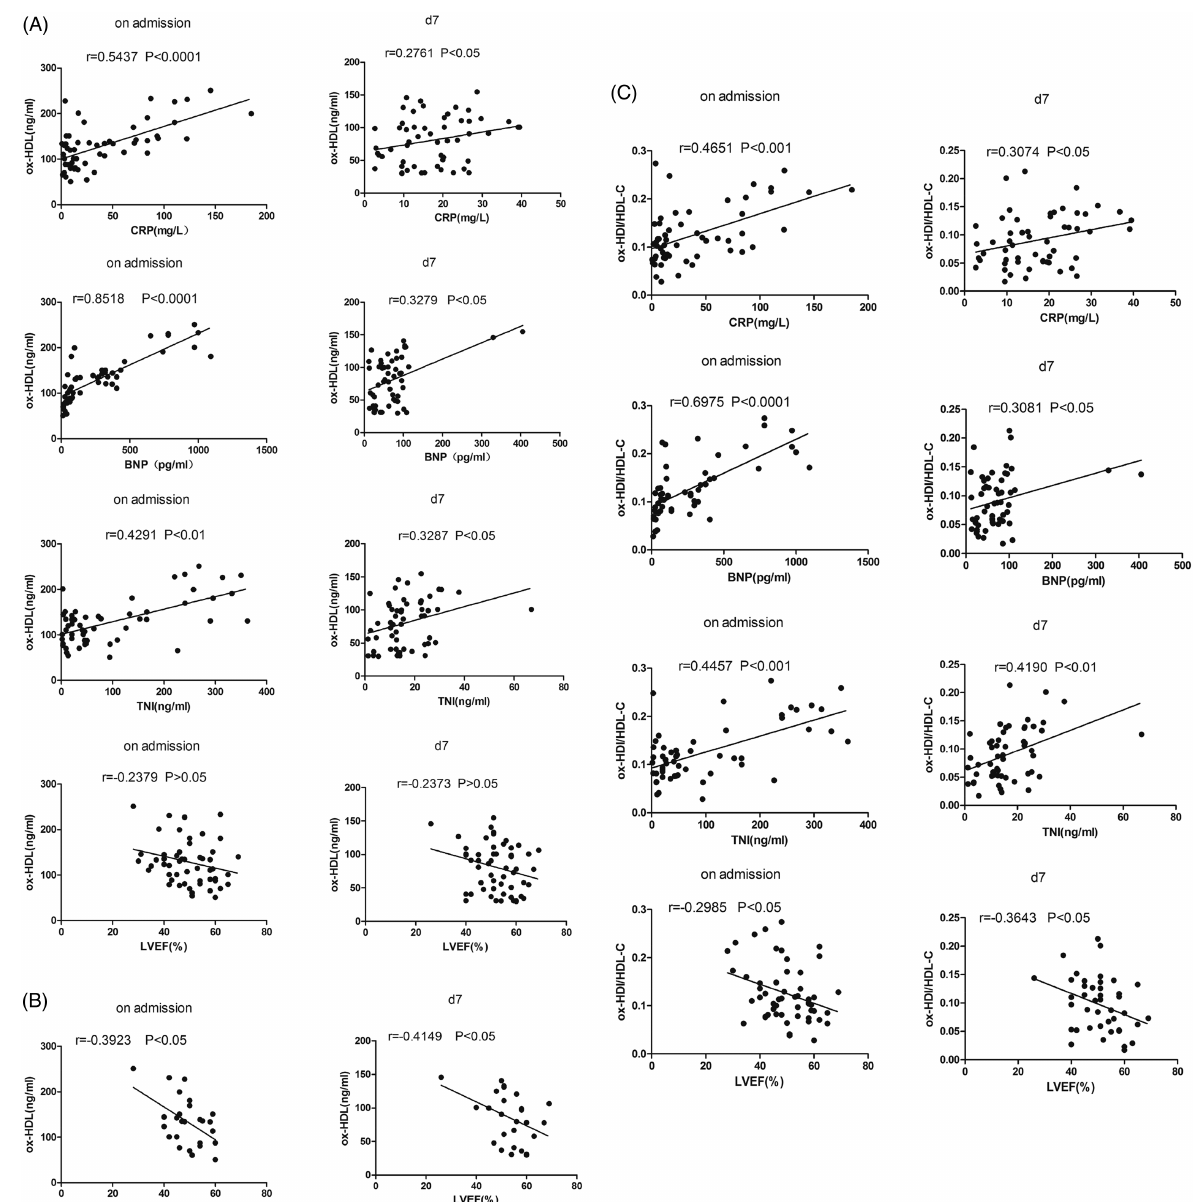
Figure 4. Spearman ’ s correlation analysis. (A) Plasma ox-HDL concentrations were positively correlated with CRP, BNP, and cTNI and were not correlated with LVEF in STEMI patients at each time point. (B) In patients whose culprit vessels were LAD, ox-HDL concentrations were negatively correlated with LVEF. (C) Ox-HDL/HDL- C levels were positively correlated with CRP, BNP, and cTNI and negatively correlated with LVEF at each time point. Data are presented as